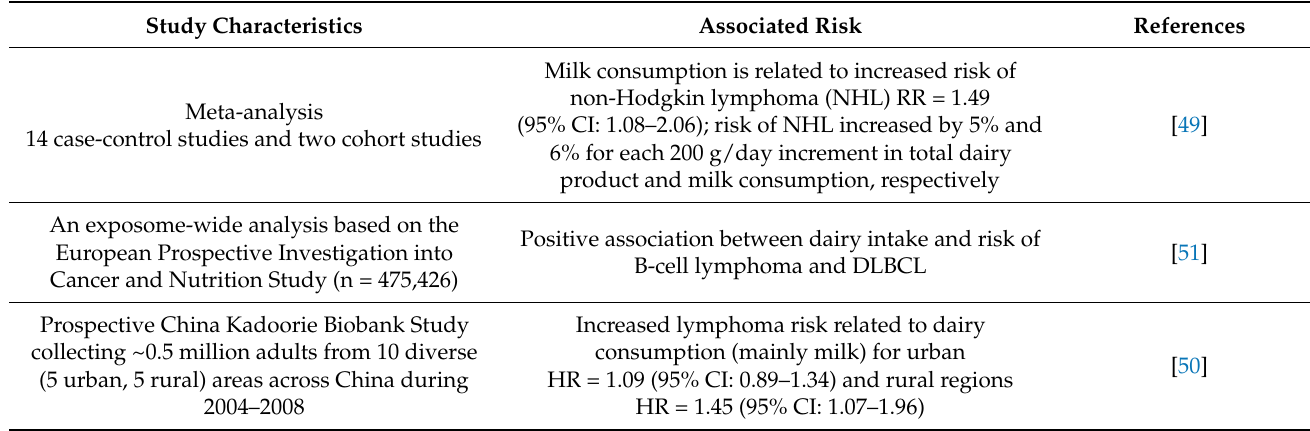
Table 1. Recent epidemiological evidence for milk and dairy product consumption related to in- creased risk for B-cell lymphoma and